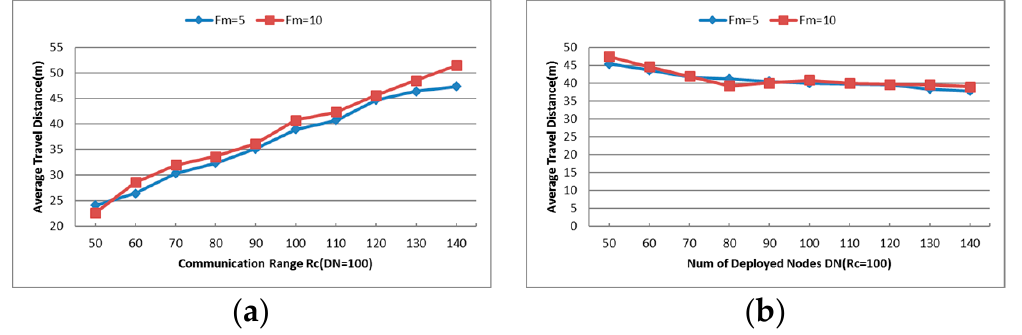
Figure 17. ( a ) TD with different (cid:1844)